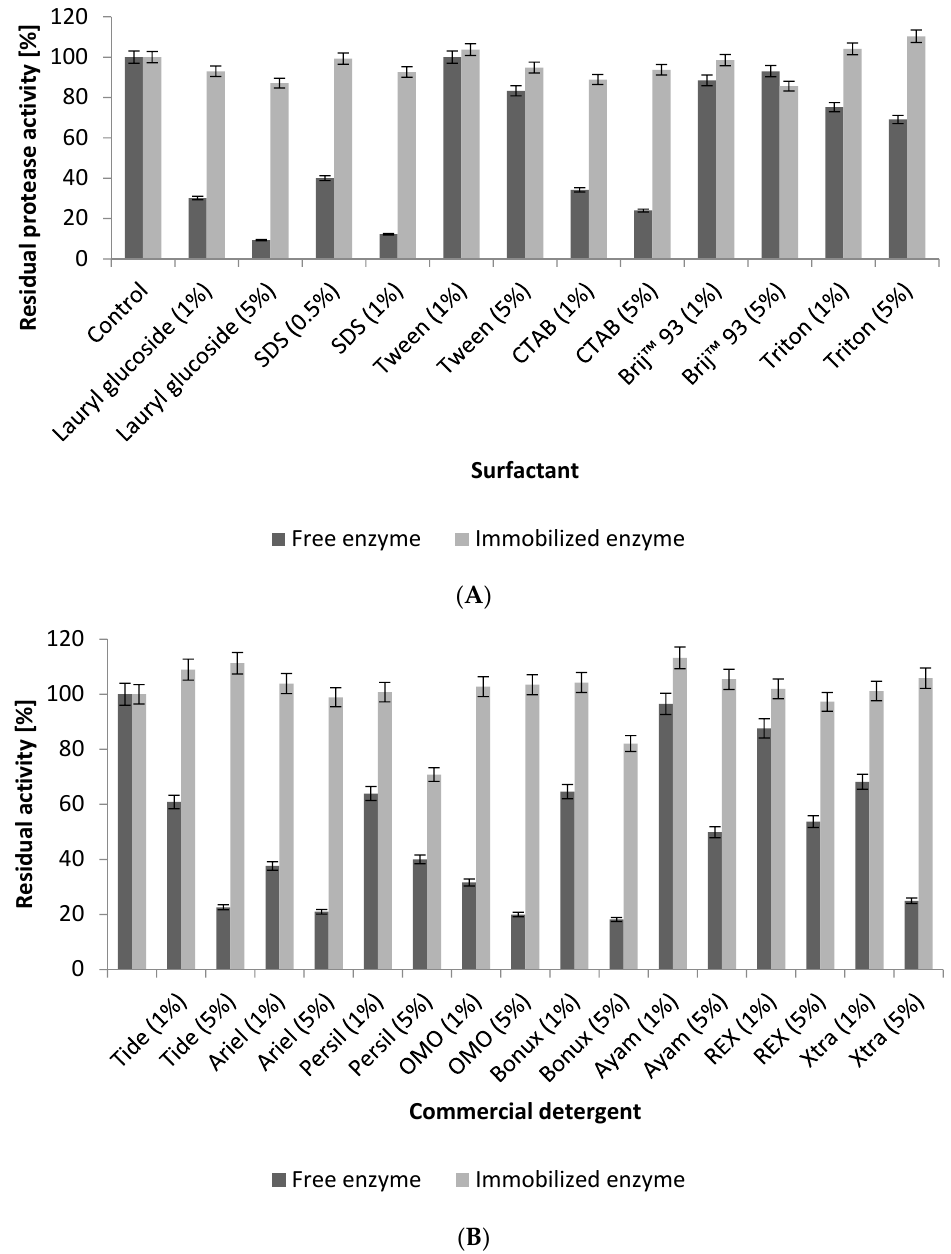
Figure 10. Effect of surfactants ( A ) and commercial detergents ( B ) on stability of free and immobilized NPST-AK15 protease stability. SDS: sodium dodecyl sulfate; CTAB: cetyltrimethylammonium bromide.